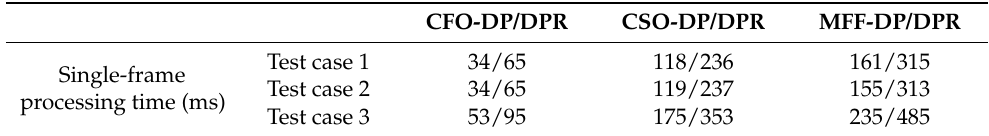
Figure 10. False alarm rates of different DP and DPR algorithms in multi-target detection. ( a ) Test case 1; ( b ) test case 2; ( c ) test case 3. Table 2. Comparison of the computational efficiencies of the DP/DPR algorithms in multi-target detection.